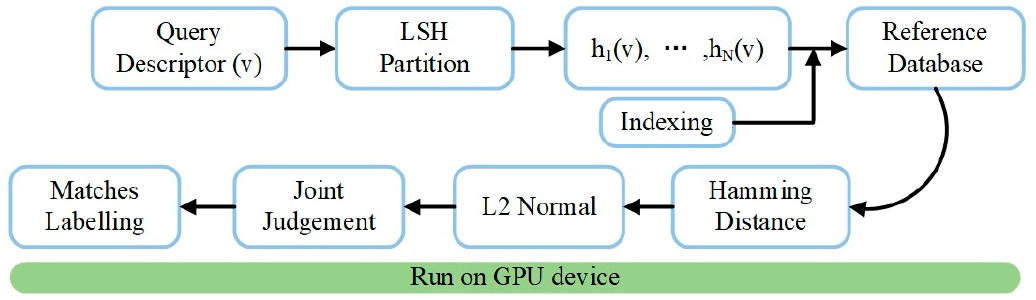
Figure 5. Flowchart of descriptor matching.